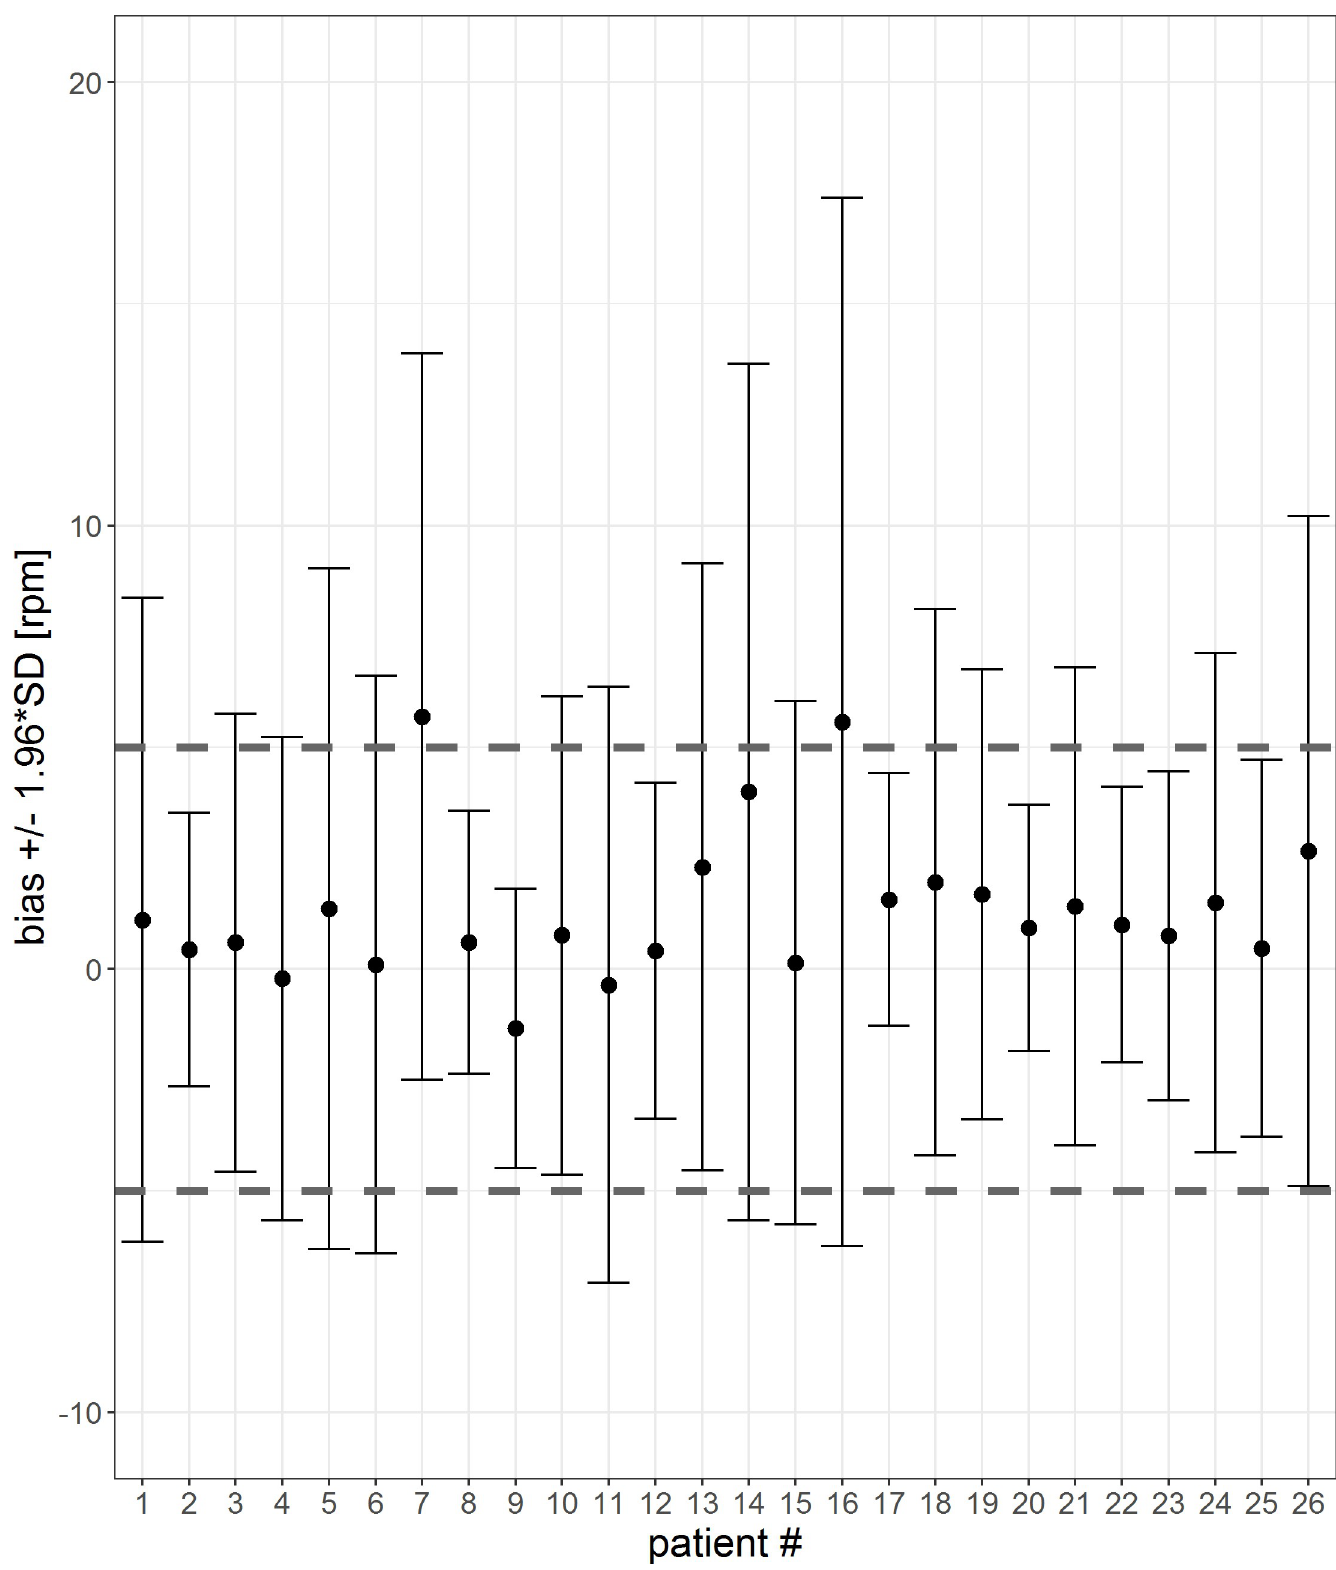
Fig 12. Error bar of each patient for a 1-sec-interval. The mean differences and confidence interval (bias +/- 1.96 � SD) for each patient are plotted. Difference was calculated by subtracting patient monitor data from Healthdot data, based on a 1-sec-period. The gray dashed lines indicate the required threshold of 5 rpm. https://doi.org/10.1371/journal.pone.0247903.g012 PLOS ONE | https://doi.org/10.1371/journal.pone.0247903 April 28,